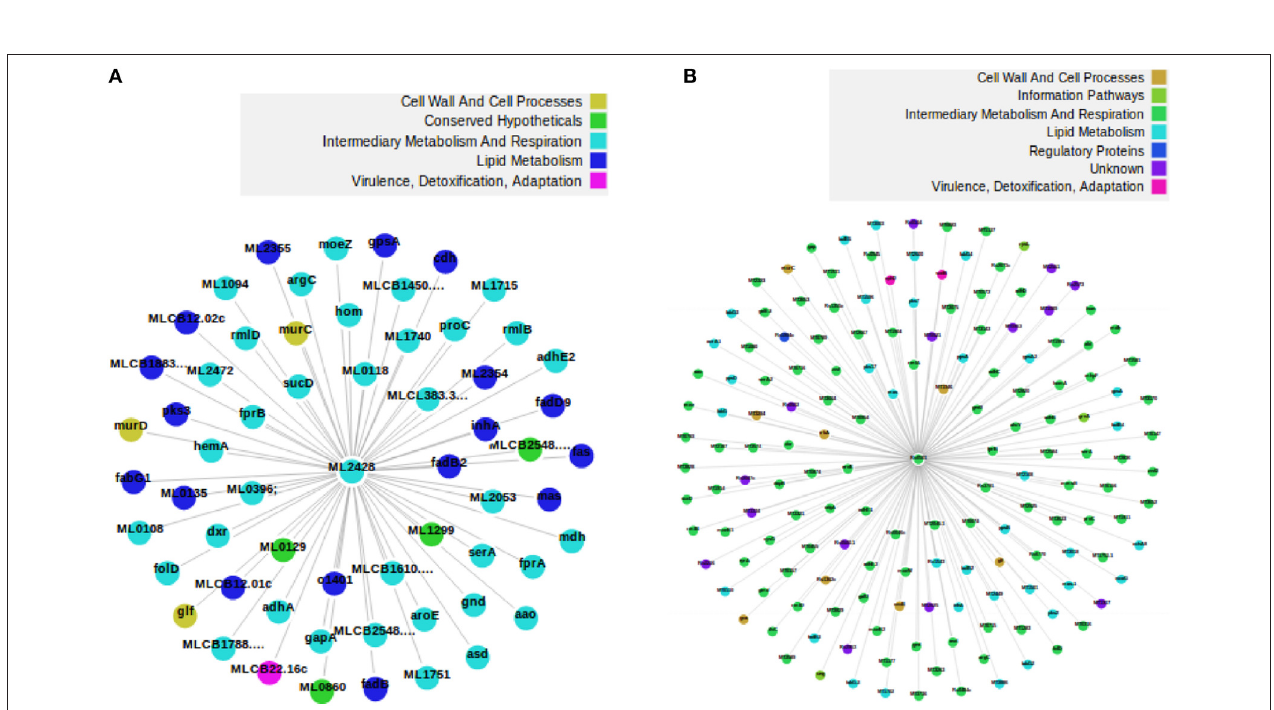
FIGURE 3 | An example of a deletion in MLP. The two proteins are orthologs in MLP (left) and MTB (right), respectively, but Q9CB57 has 90 of its neighbors deleted with respect to its ortholog network. Fifty three proteins are direct ortholog neighbors in both. (A) The protein Q9CB57 in MLP and its 60 neighbors comprising 2 non-orthologs and 58 orthologs. (B) The protein P0A5D1 in MTB and its 152 neighbors. Among the neighbors, 90 are non-orthologs while 62 are orthologs. We drew the two figures from the full network.